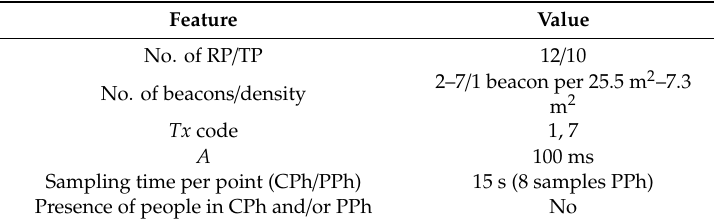
Table 14. Main features of Tests #5.